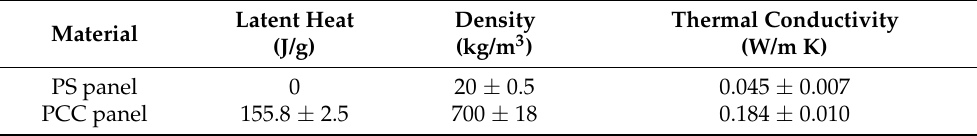
Table 3. Thermophysical properties of PCM panel and PS panel.